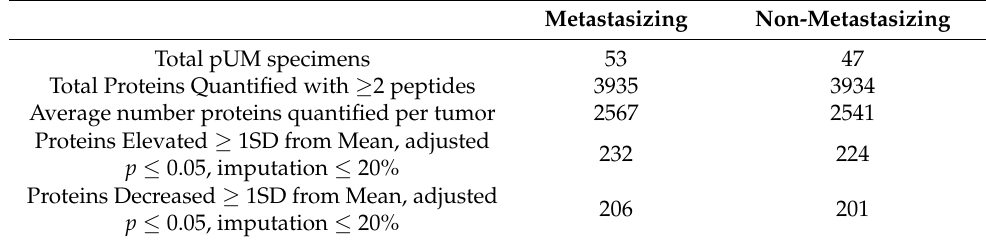
Table 1. Summary: pUM Quantitative Proteomic Results.